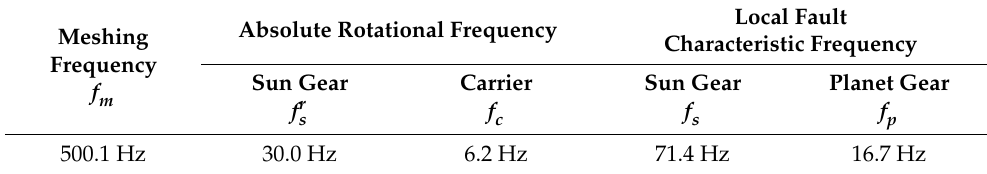
Table 2. Simulation of planetary gearbox characteristic frequency.